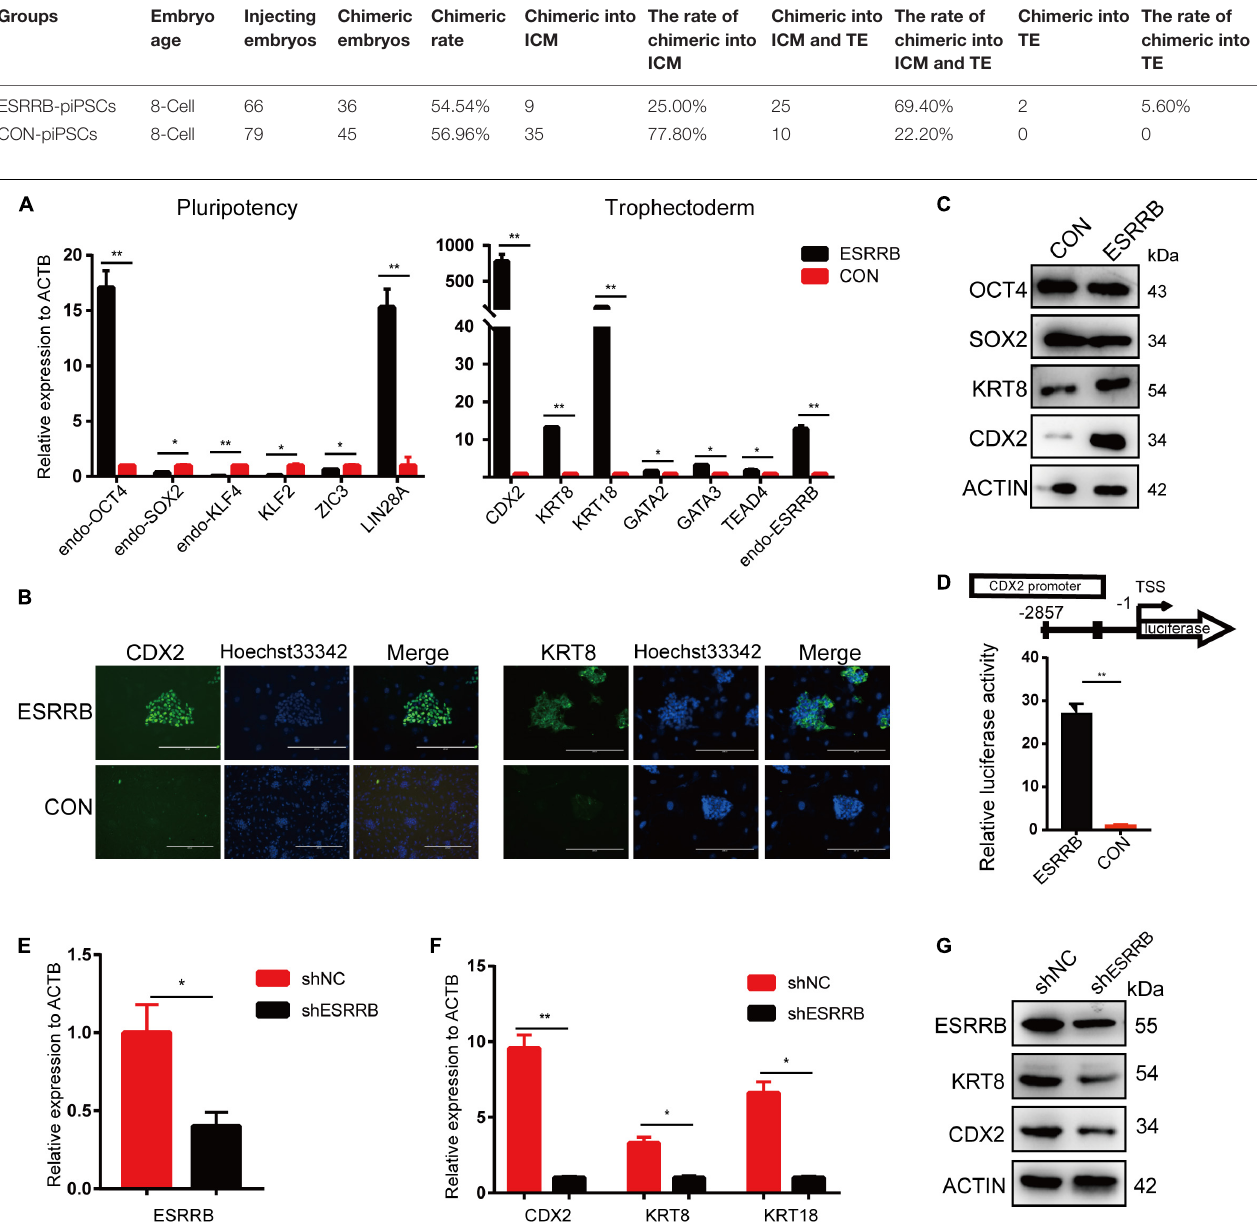
TABLE 5 | The rate of contributing cell localization in embryos. Groups